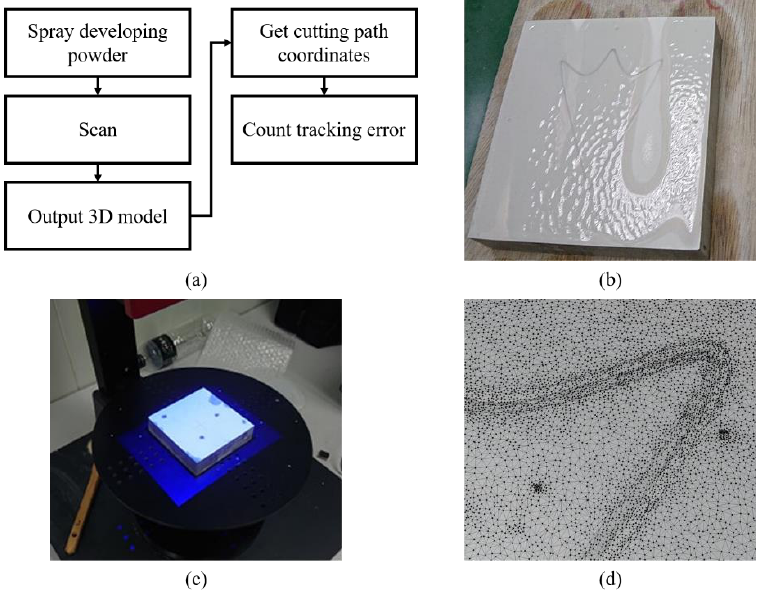
Figure 12. ( a ) Flowchart of optical 3D scanner measurement, ( b ) spraying of developing powder, ( c ) scanning using optical 3D scanner, and ( d ) 3D graphics after scanning aluminum workpieces.